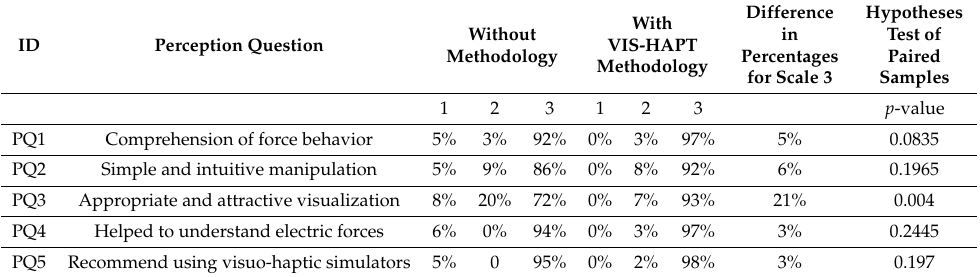
Table 5. Hypotheses test of the paired samples of the perception survey with and without methodology.